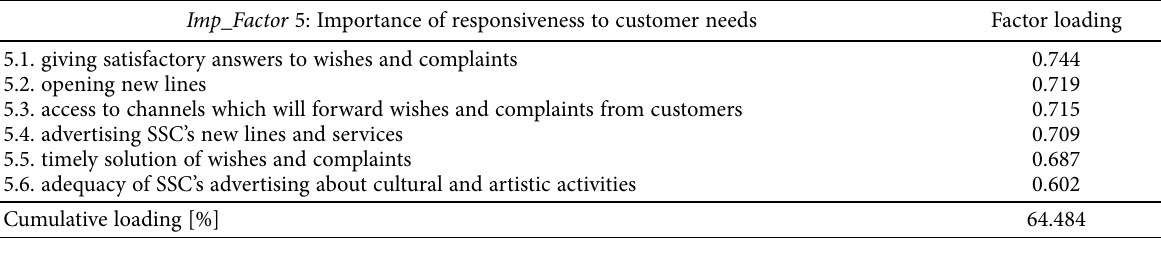
Table 15. Importance Factor 5 factor loadings